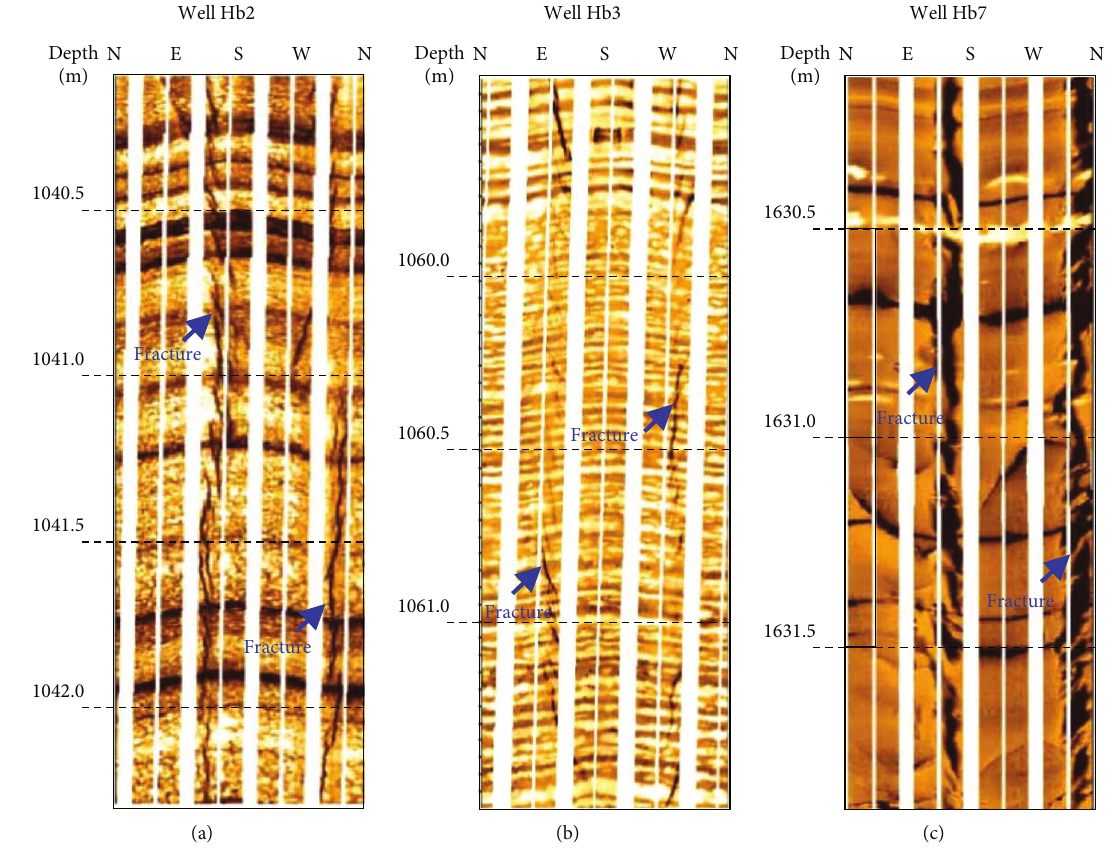
Figure 4: Borehole image logs showing drilling-induced tensile fractures (DITFs) and wellbore breakouts (WBs) in the Haiba Block.